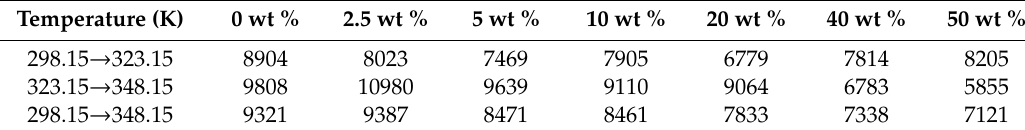
Table 2. B under di ff erent temperature changes.